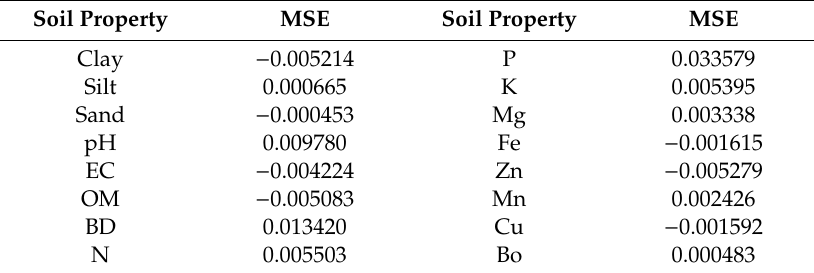
Table 3. The mean standardized errors (MSE) derived for the Kriging surfaces.